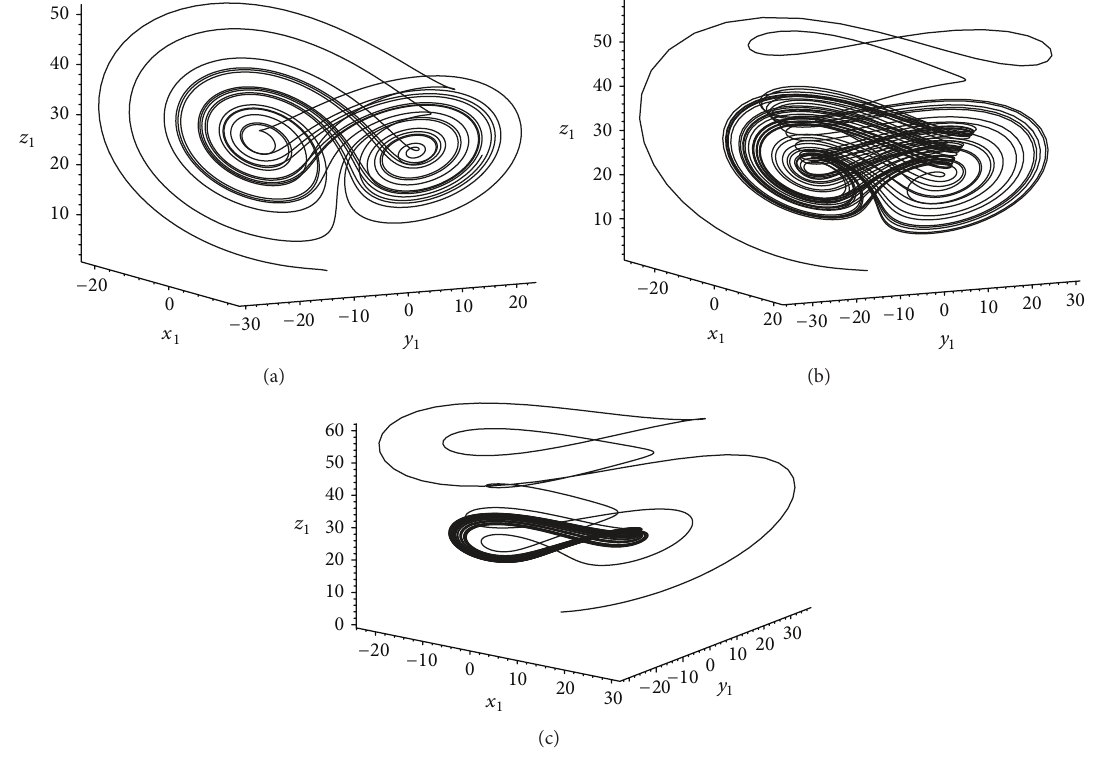
Figure 1: Generlized chaotic attractors: (a) Lorenz, (b) L¨u, (c) Chen.